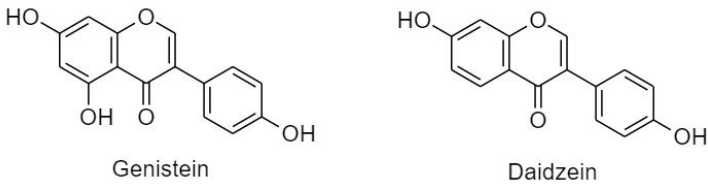
Figure 11. Classification and structure of isoflavonoids.